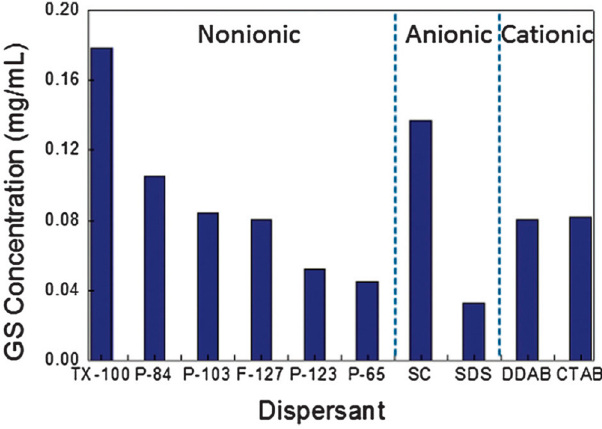
Figure 19. Graphene sheets concentration by tip–bath–tip (TBT) sonication for various dispersants, using identical TBT sonication treatment (integrated energy 23 kJ; 9 min tip sonication, 3 h bath sonication, and 9 min tip sonication). Reproduced from [50]. Copyright Owner Societies, 2013.